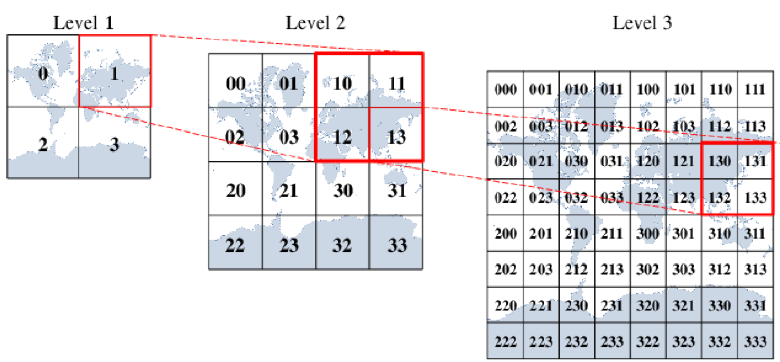
Figure 2. Hierarchical structure and inclusion relation of Quadkey